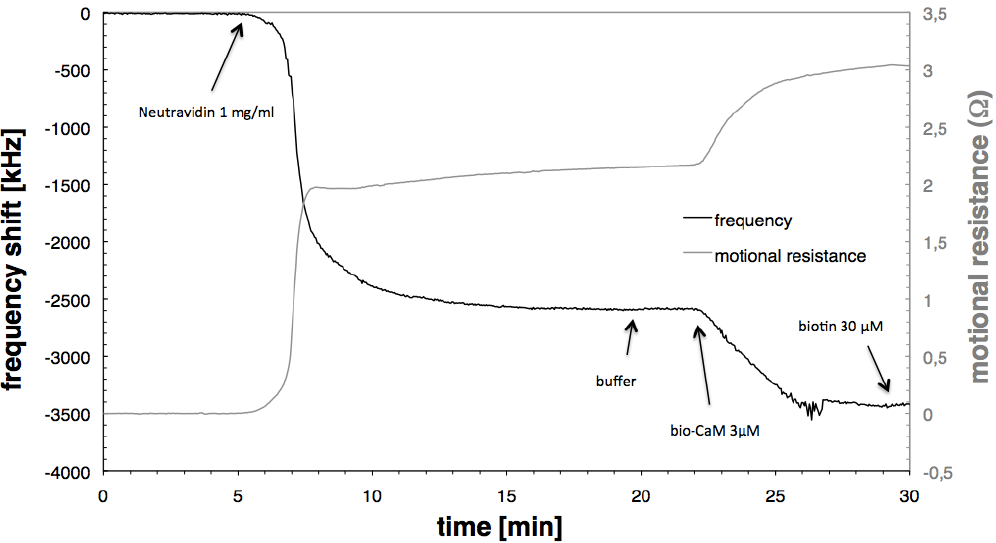
Figure 1. Resonant frequency shift and motional resistance change during Neutravidin adsorption and binding of biotinylated calmodulin.